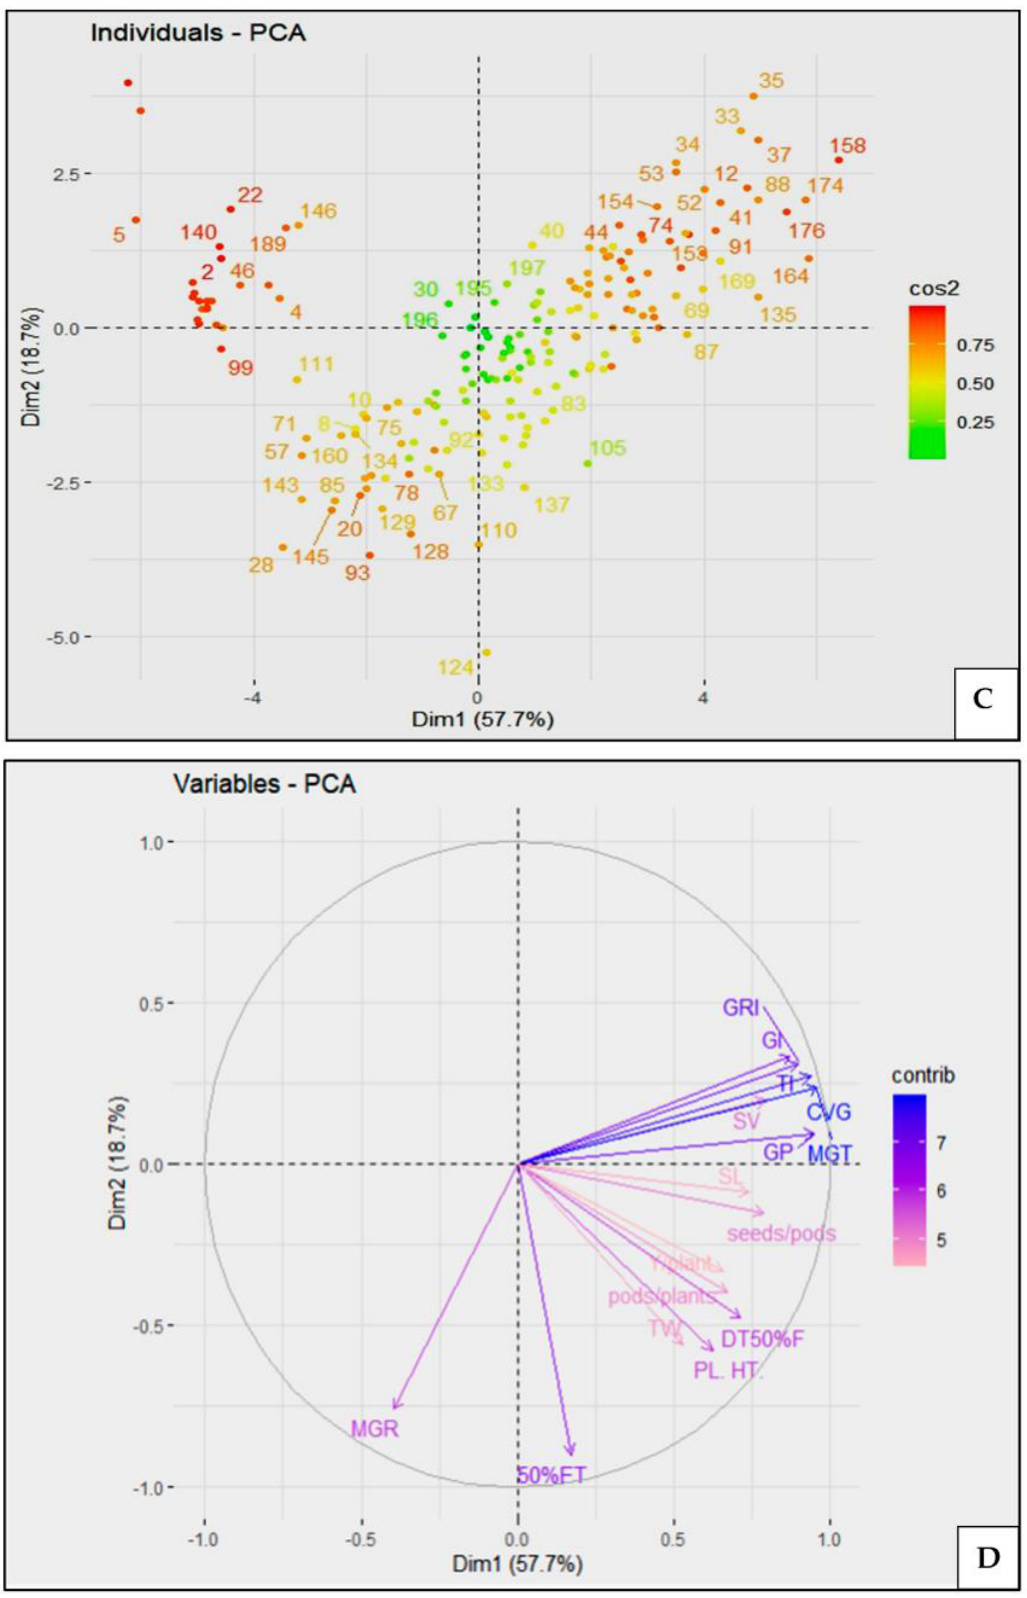
Figure 3. Individual PCA plots showing clusters based on similarity of samples. PCA analysis at ( A , B ) 22 °C and ( C , D ) 10 °C. The quality of representation of the variables on factor map is indicated by cos2 (square cosine, squared coordinates). A cos2 value correlates with the color and resistance to cold ac- cordingly if present in positive quadrant and vice-versa. Dim indicates Dimensions/Principal compo- nents. The red dots represent the genotypes and the grey arrow represents the traits or the variables that are taken into consideration.